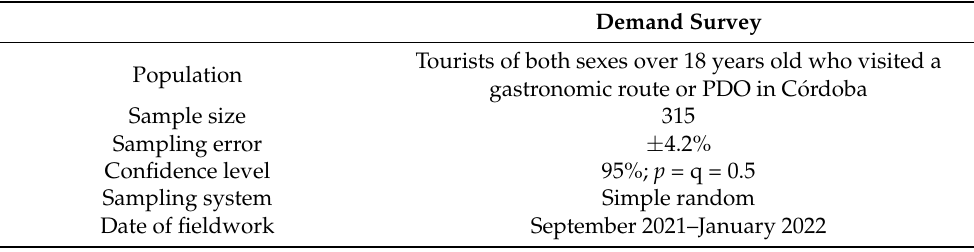
Table 2. Technical aspects of the